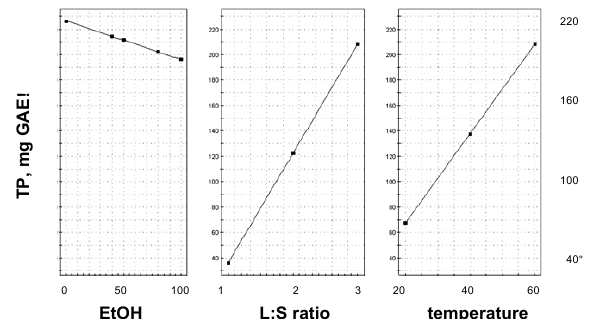
Fig. 2: Prediction plots of the considered factors: EtOH% (L:S ratio 3 and temperature 60 °C); L:S ratio (EtOH 60% and temperature 60